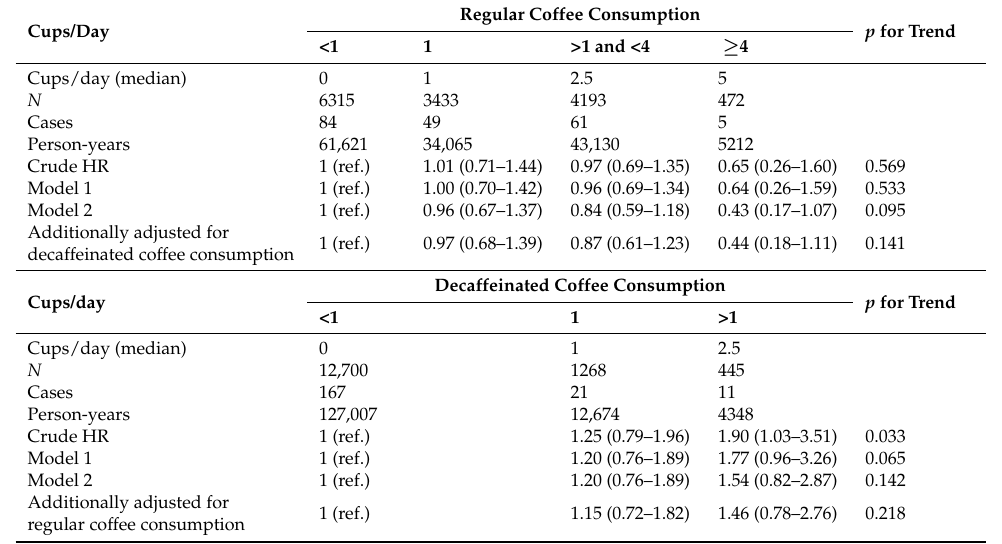
Table 3. Subgroup analysis. Hazard ratios (95% confidence intervals) for incidence of depression according to baseline regular and decaffeinated coffee